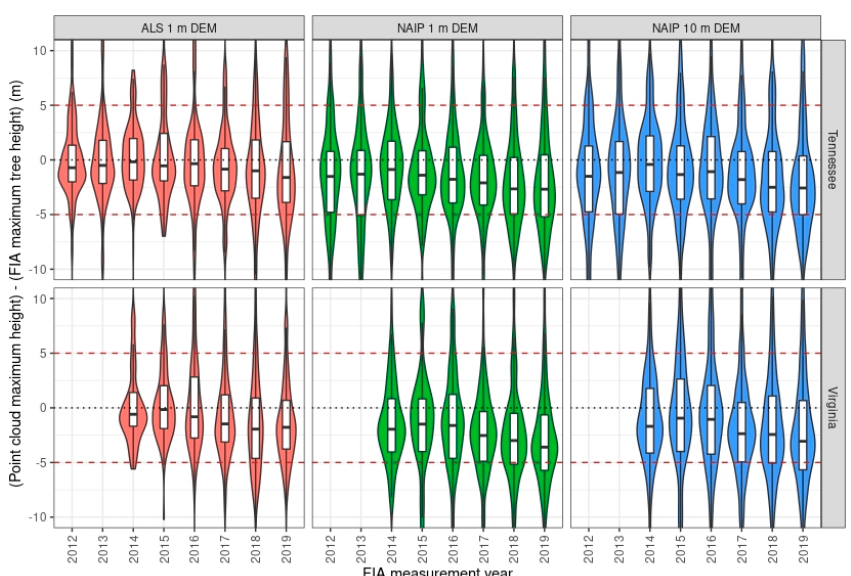
Figure 6. Differences between FIA maximum tree height and point cloud maximum height by FIA measurement year. Dashed red lines are drawn at +/ − 5 m and dashed black lines at zero. For the boxplots, the bottom and top of the rectangles span the 25% to 75% height range, while the thick black bars are the median values. Columns break out the plots by point cloud source (ALS or NAIP) and DEM resolution (1 m and 10 m), while rows highlight the data collected in different states (TN top, VA bottom).